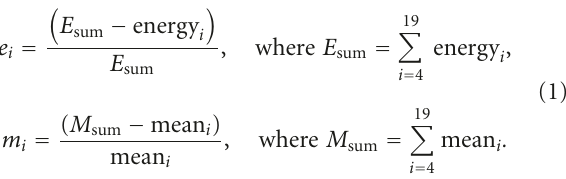
The analysis filter bank is cascaded several times until it decomposes the image into the desired 64 spatial frequency subbands. Figure 3 is a visualization of the SWT decomposi- tion